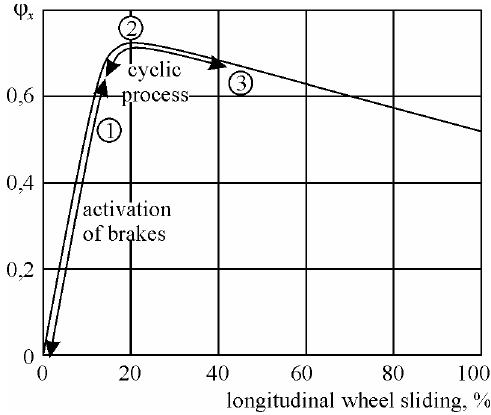
Fig 2. The response of the coefficient of cohesion of tyres with the surface of the